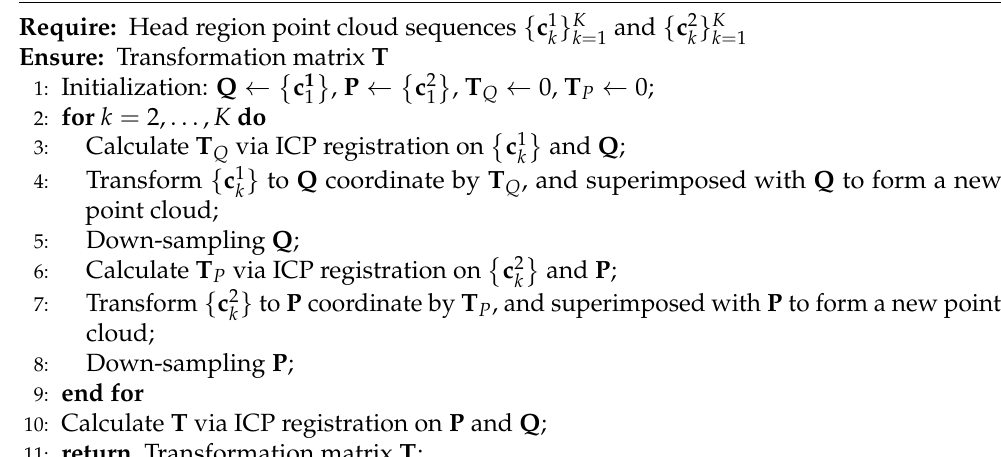
Figure 3. Frame of multi-frame point cloud fusion (MFPCF). Algorithm 2 : Multif-frame point cloud fusion and